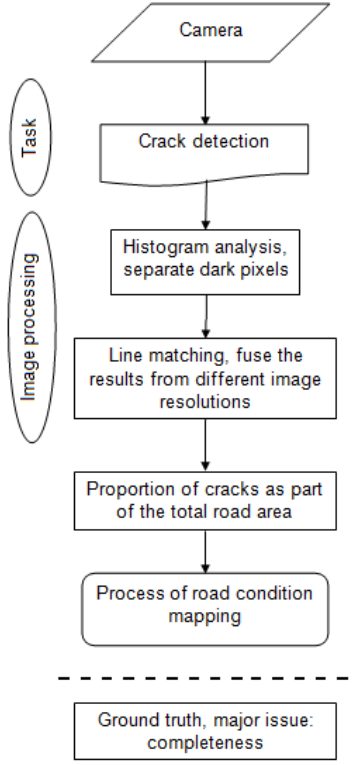
Figure 6. Flowchart of crack detection using RGB images